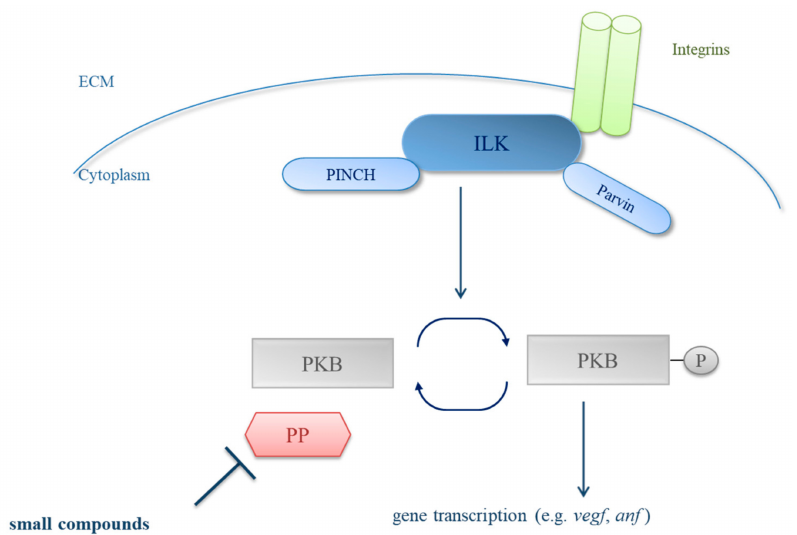
Figure 1. Schematic illustration of the integrin-linked kinase-protein kinase B (ILK-PKB) signaling pathway. Integrin-linked kinase forms, together with PINCH (particularly interesting Cys-His-rich protein) and parvin, the ILK-PINCH-parvin (IPP) complex and mediates signals from the extracellular matrix (ECM) to the cytoplasm through integrins. The phosphorylated downstream target PKB facilitates the expression of stretch responsive genes such as the atrial natriuretic factor ( anf ), thereby effectively transducing signals from the cardiac stretch sensor. Reduced PKB phosphorylation in ILK deficient main squeeze mutant zebrafish hearts was demonstrated to lead to impaired cardiac contractility and heart failure [10]. In this context, the inhibition of protein phosphatases (PP) by small chemical compounds that results in an increase of PKB phosphorylation might be a promising therapeutic approach to treat ILK-associated